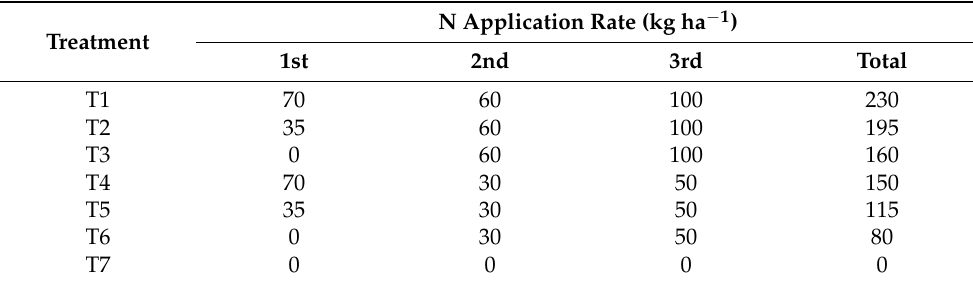
Figure 2. Layout of lysimeters with N treatments. Treatments (T1–T7) refer to the different N fertilizer application treatments shown in Table 2. Table 2. N fertilizer application rates used in the first, second, and third applications for each treatment (T1–T7).